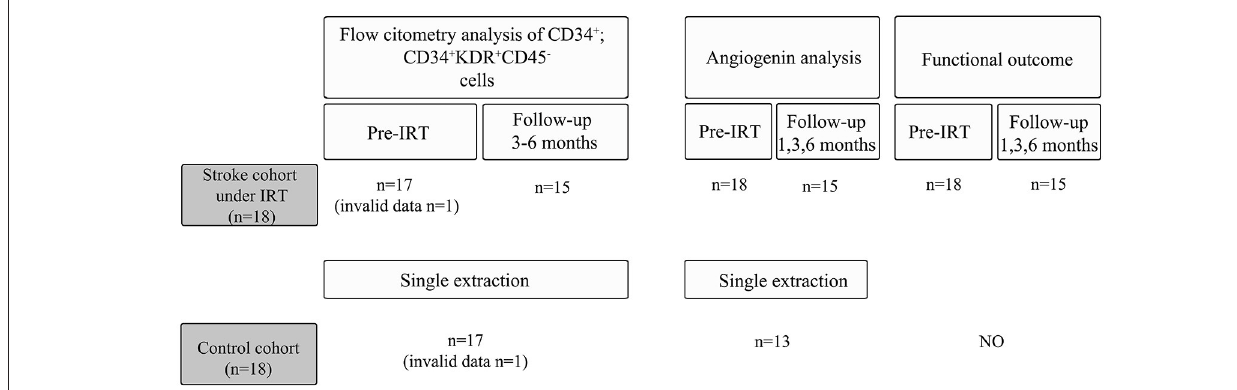
FIGURE 1 | Study overview for the control and the stroke cohort.